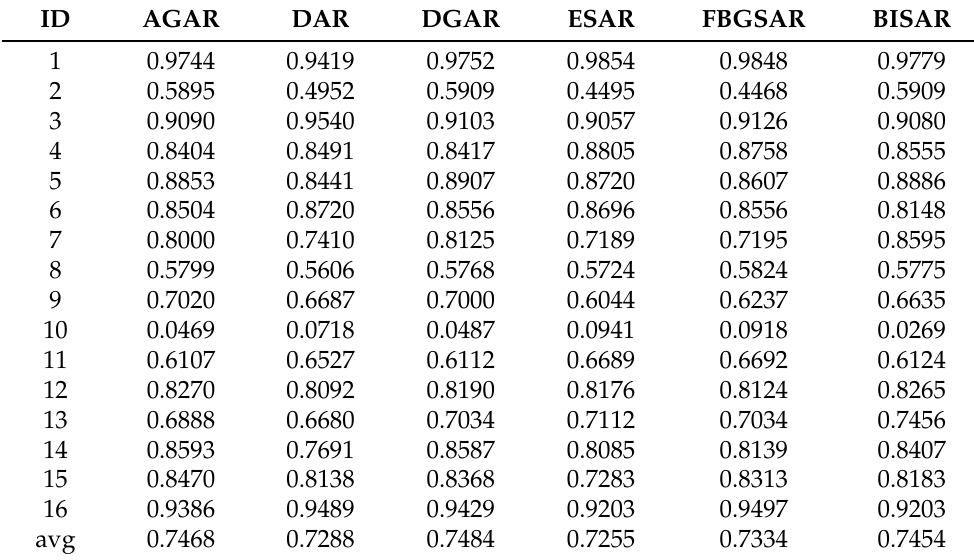
Table 11. Classification accuracies based on SVM classifier (raw